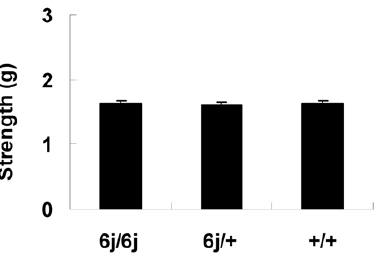
Figure 2. Muscle strength in the grip strength test. The 6j / 6j ( n= 10), 6j / + ( n= 10), and + / + mice ( n= 10) were examined in motor behavior tests.